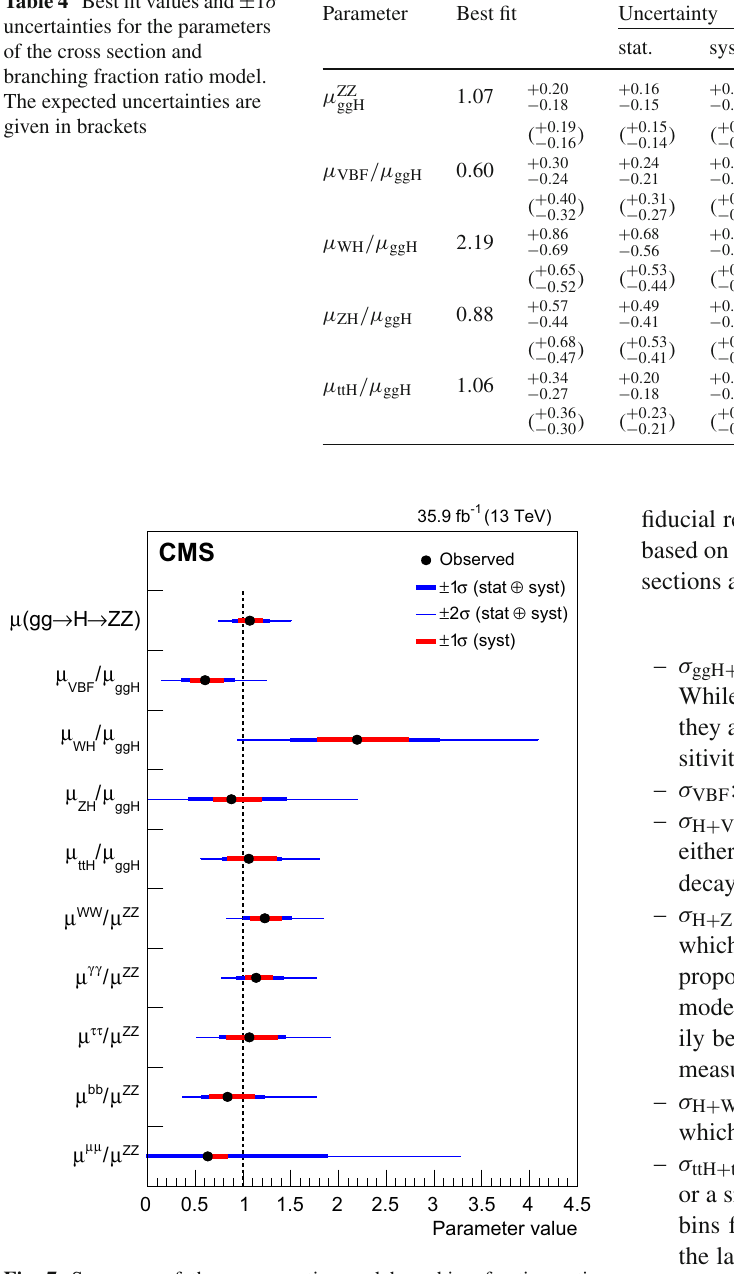
Fig. 7 Summary of the cross section and branching fraction ratio model. The thick and thin horizontal bars indicate the ± 1 σ and ± 2 σ uncertainties, respectively. Also shown are the ± 1 σ systematic compo- nents of the uncertainties